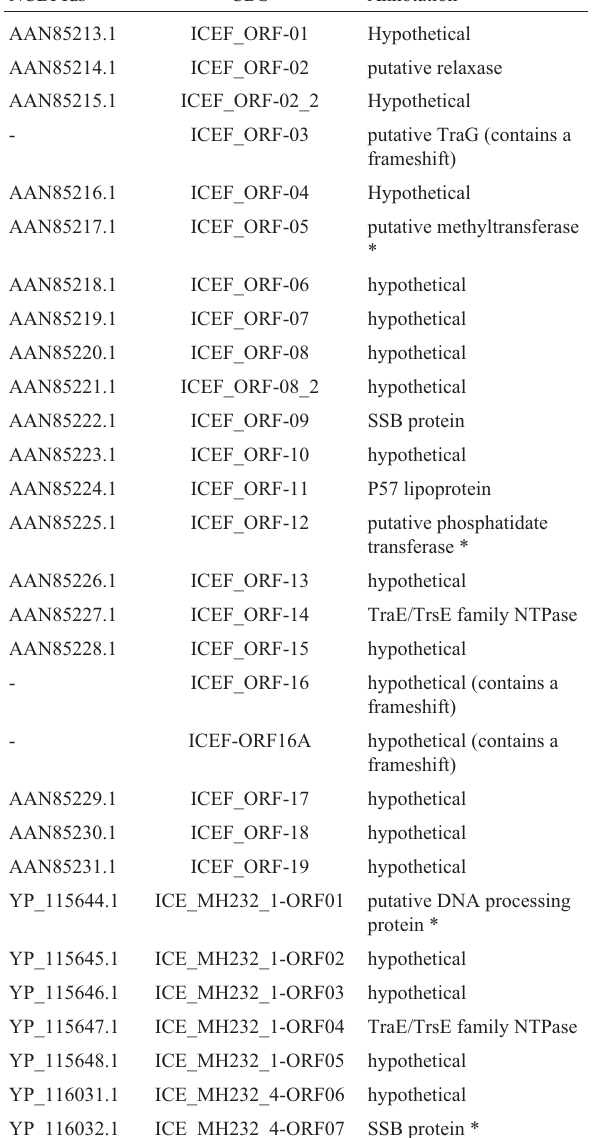
Table 1 - Annotated CDS of the elements ICEH7448, ICEH232 and ICEF. NCBI